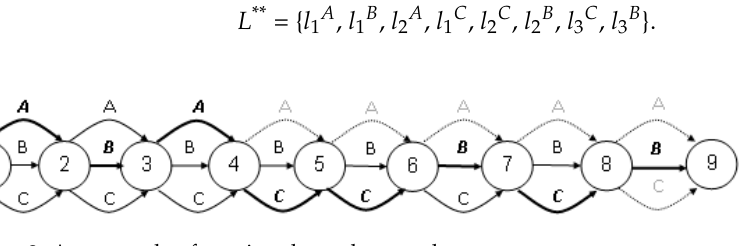
Figure 3. An example of passing through a graph.